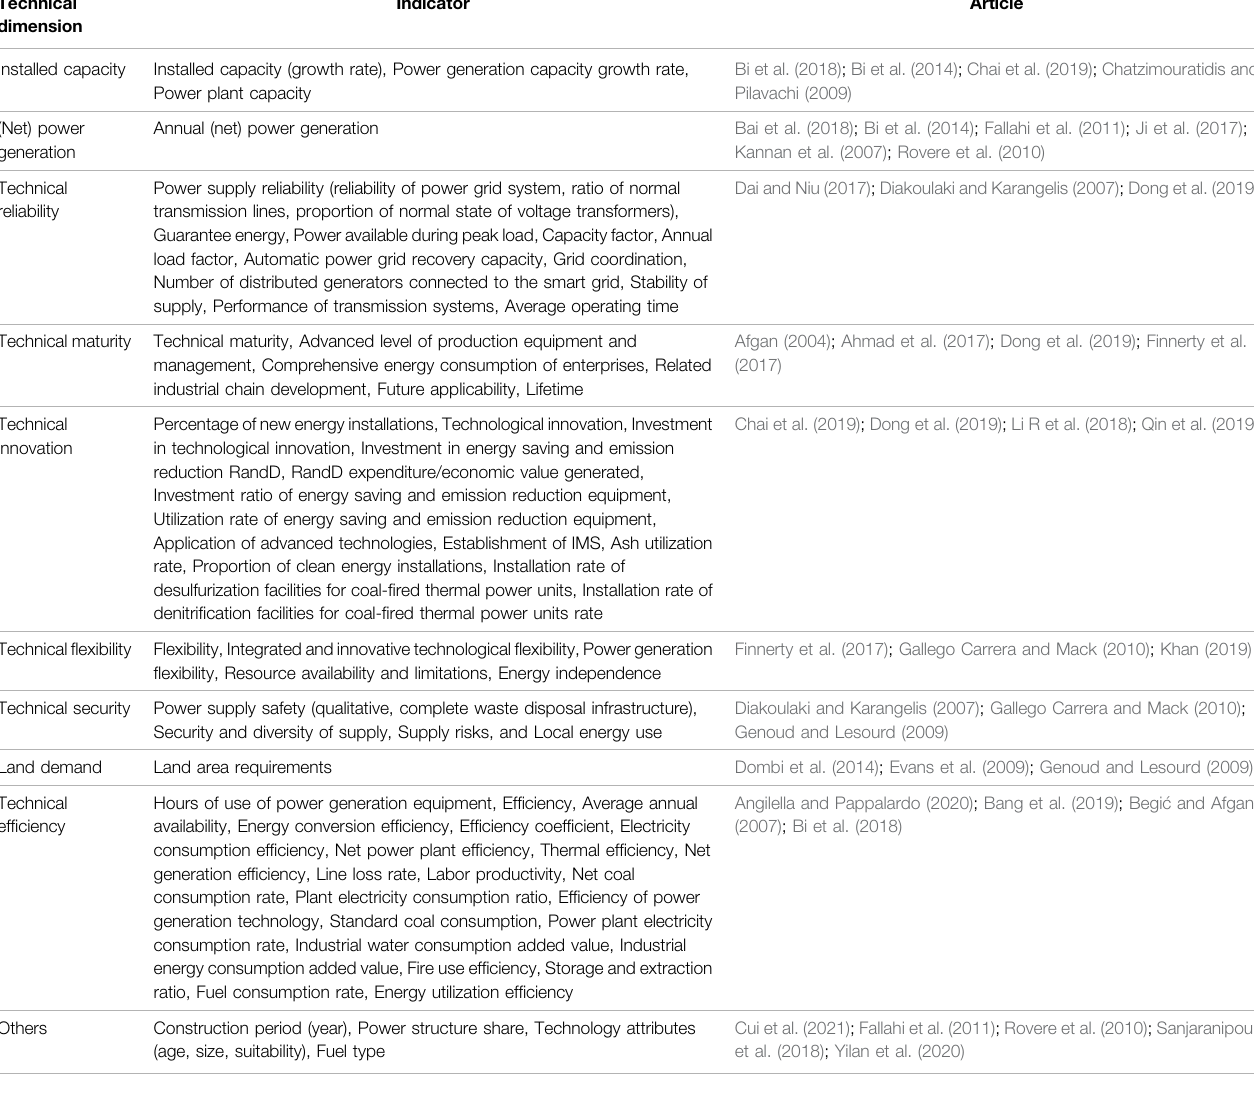
TABLE 10 | Summary of technical sustainability indicators. Technical dimension